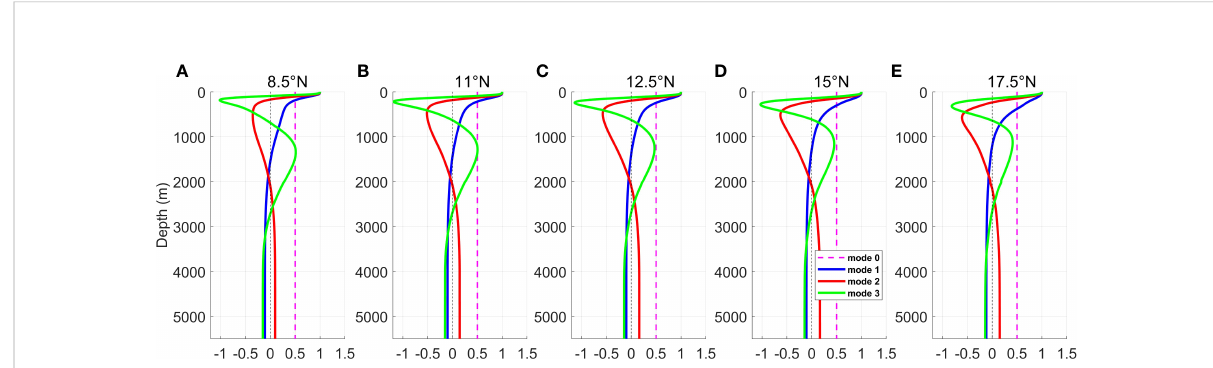
FIGURE 10 Vertical structure of the barotropic mode and fi rst three baroclinic modes at (A) 8.5°N, (B) 11°N, (C) 12.5°N, (D) 15°N, and (E) 17.5°N along 130°E calculated with the climatological mean density pro fi le from the